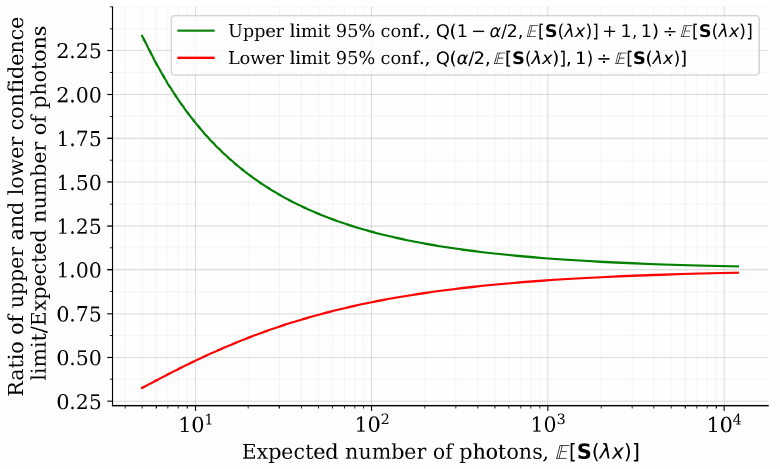
Figure 4. The relative 95% confidence interval ( α = 0.05) of the reflectance estimate with respect to the expected number of photons per channel. Both the upper limit η upper (green curve) and the lower limit η lower (red curve) converge towards unity (absolute reflectance estimation certainty) as the photon count